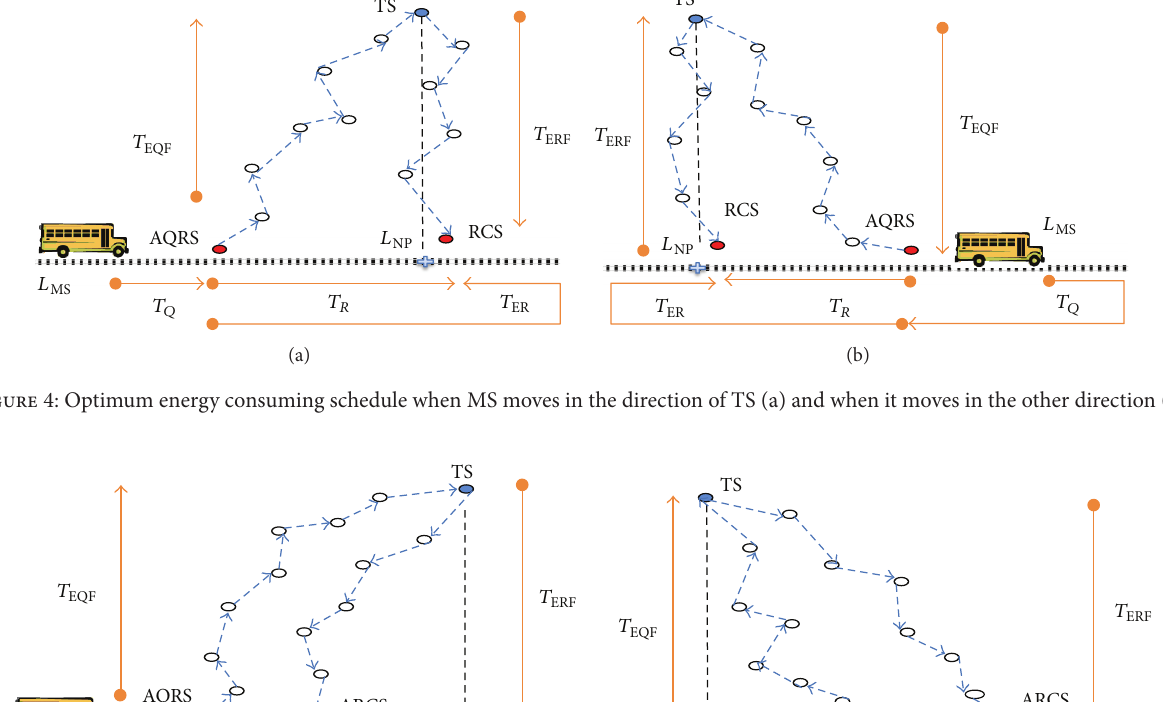
would be ready at RCS before MS reaches it. If this option fails as well, we call MECS to create an alternative